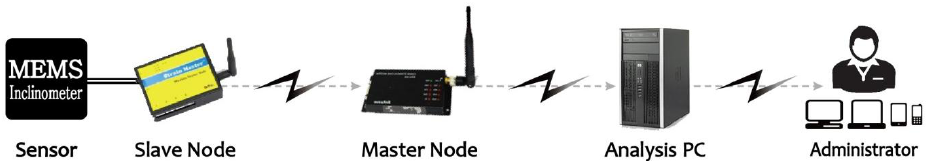
Figure 7. Wireless MEMS inclinometer sensor system.